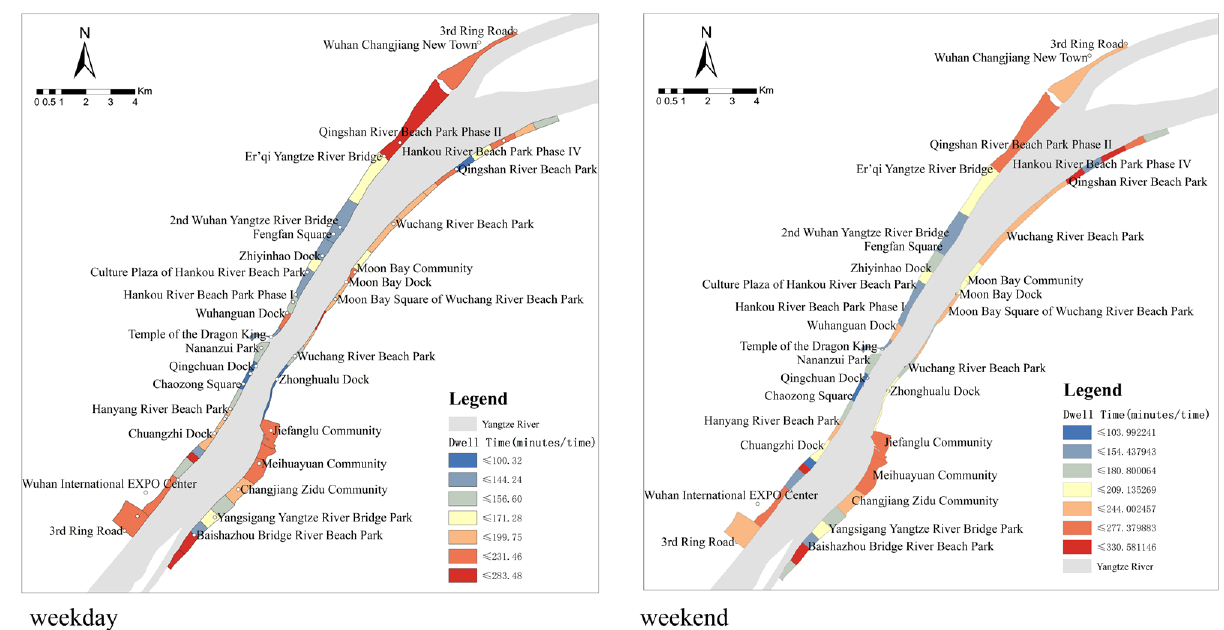
Figure 6. The space diversity distribution of the riverside area of Wuhan.